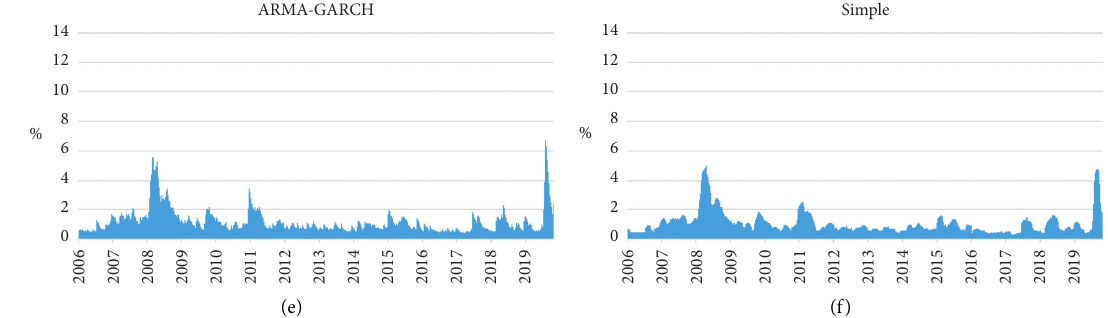
Figure 7: Volatilities of S&P 500 that the models forecast on the test period.